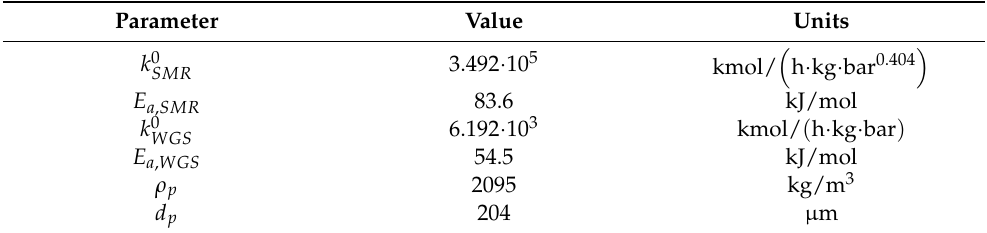
Table 3. Catalyst parameters for reaction rate